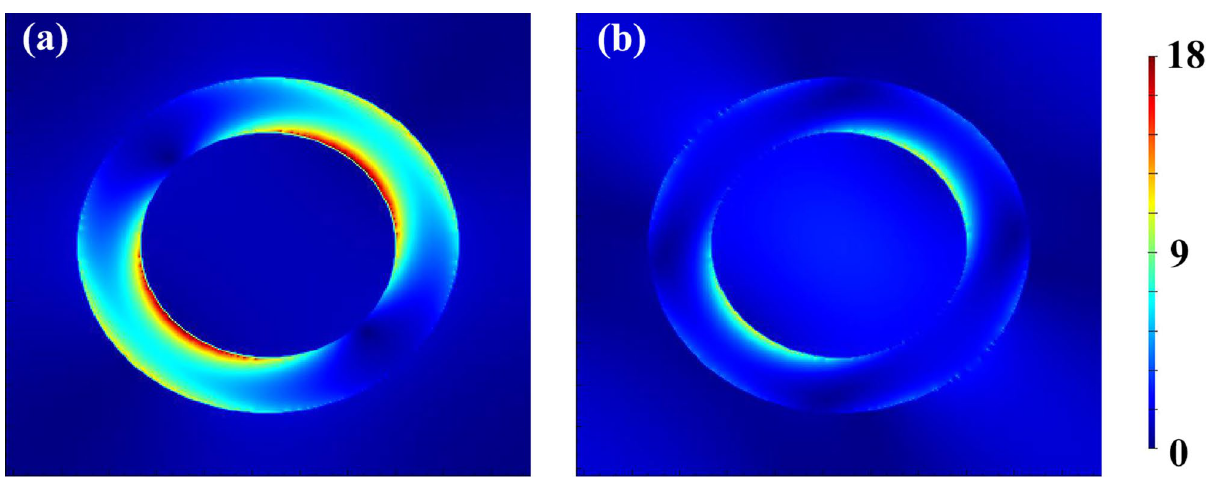
Figure 3. Electric field distribution of xy -polarized incident light of the structures in Fig. 2. The wavelength is ( a ) 1075 nm and ( b ) 800 nm, respectively. The parameters are r 1 = r 2 = 80 nm, R 1 = R 2 = 120 nm, h = 8 nm, and p = 330